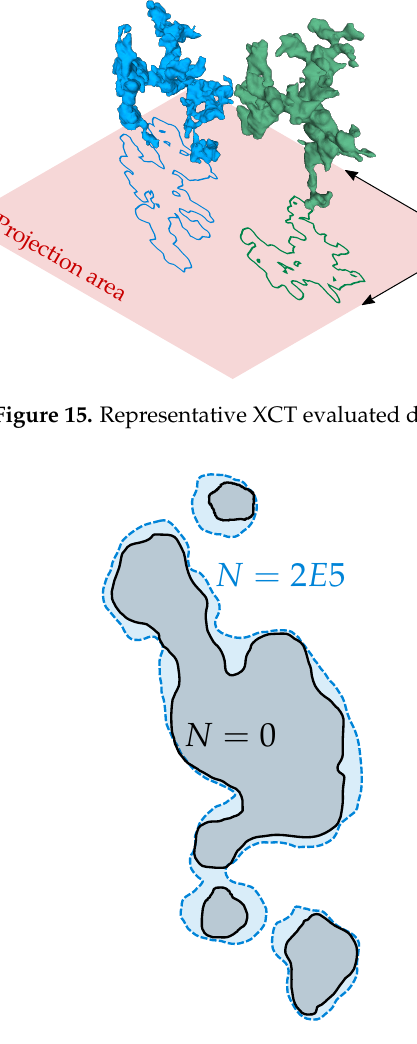
Figure 16. Evaluated crack propagation based on in situ XCT after 2E5 load evaluated Figure 15. Representative XCT